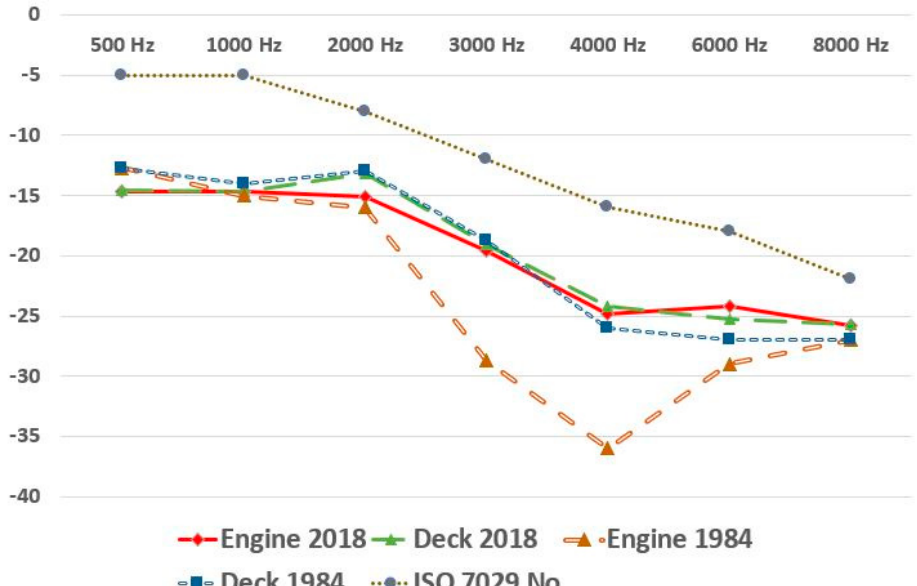
Figure 2. Comparison of median audiograms of seafarers over 40 year timespan (deck/marine engineers) between 1984 data (Jegaden), 2018–2019 data from our study, and the normal physiological audiometric curve according to ISO 7029 corresponding to the age class.